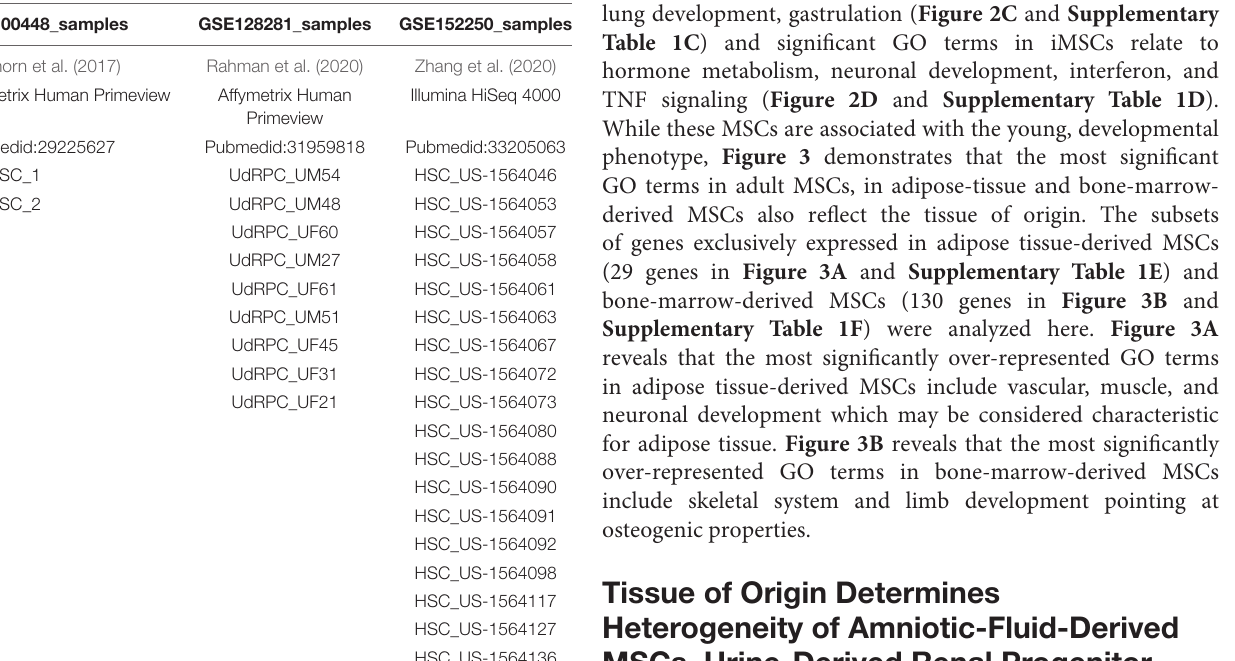
TABLE 2 | Samples of amniotic-fluid-derived MSCs (AF-MSCs), urine-derived progenitor cells (UdRPCs), and hepatic stellate cells